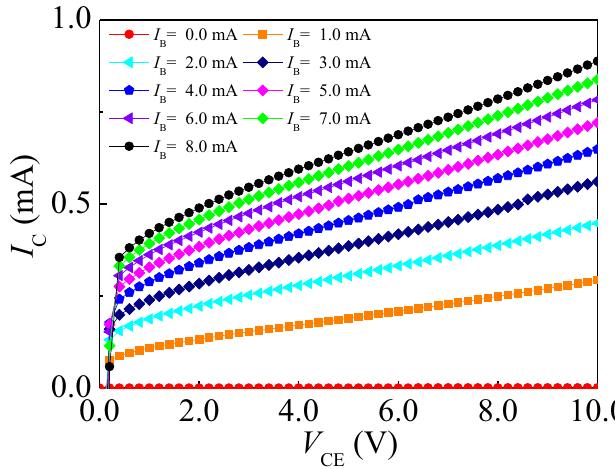
Figure 6. I C – V CE characteristic curves of the HSMST.